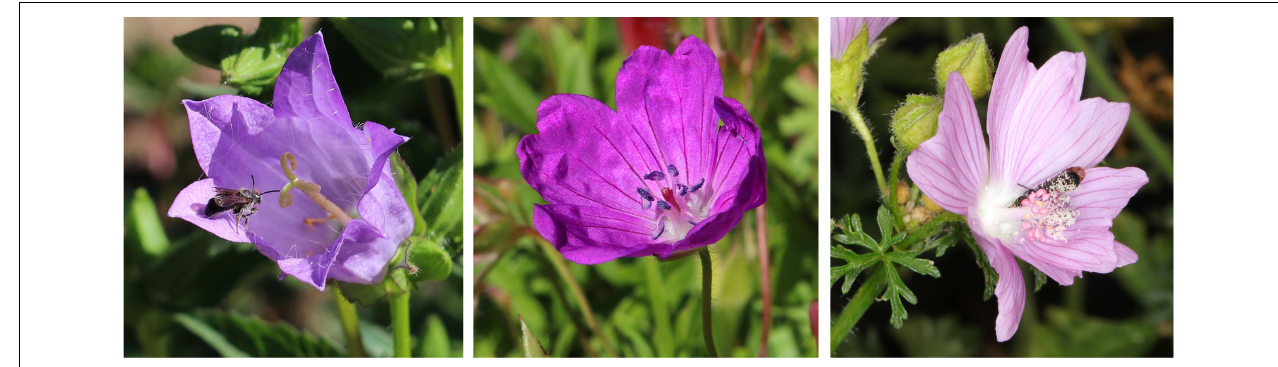
FIGURE 1 | Flowers of the studied plant species Campanula trachelium , Geranium sanguineum , and Malva moschata and flower-visiting Chelostoma rapunculi females (left and right photograph).